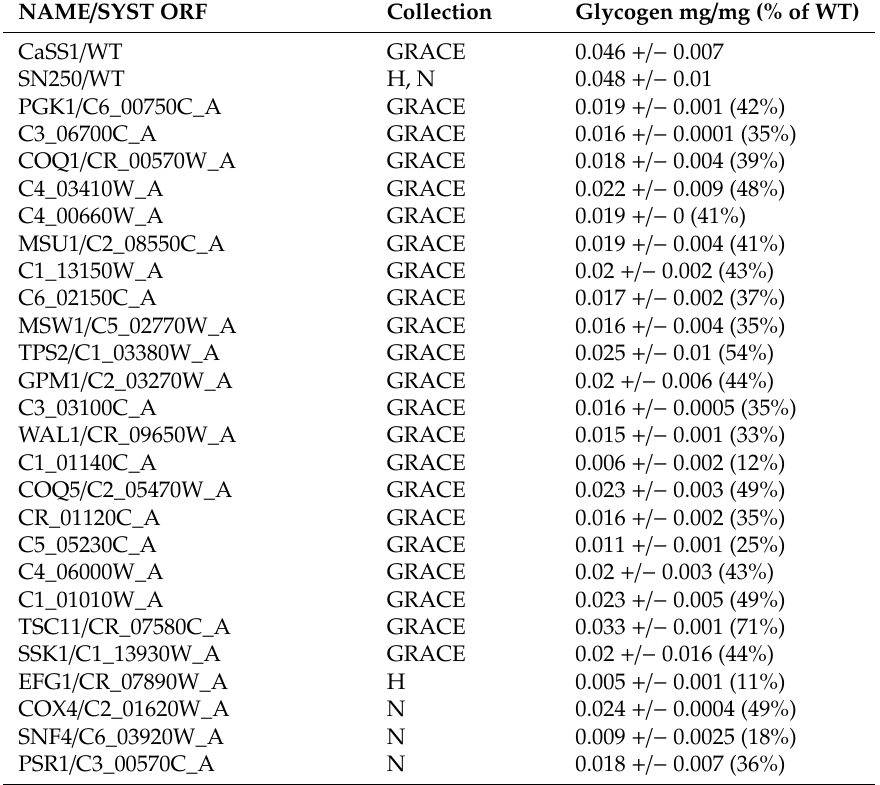
Table 2. List of mutants with low glycogen content isolated in the library screen.